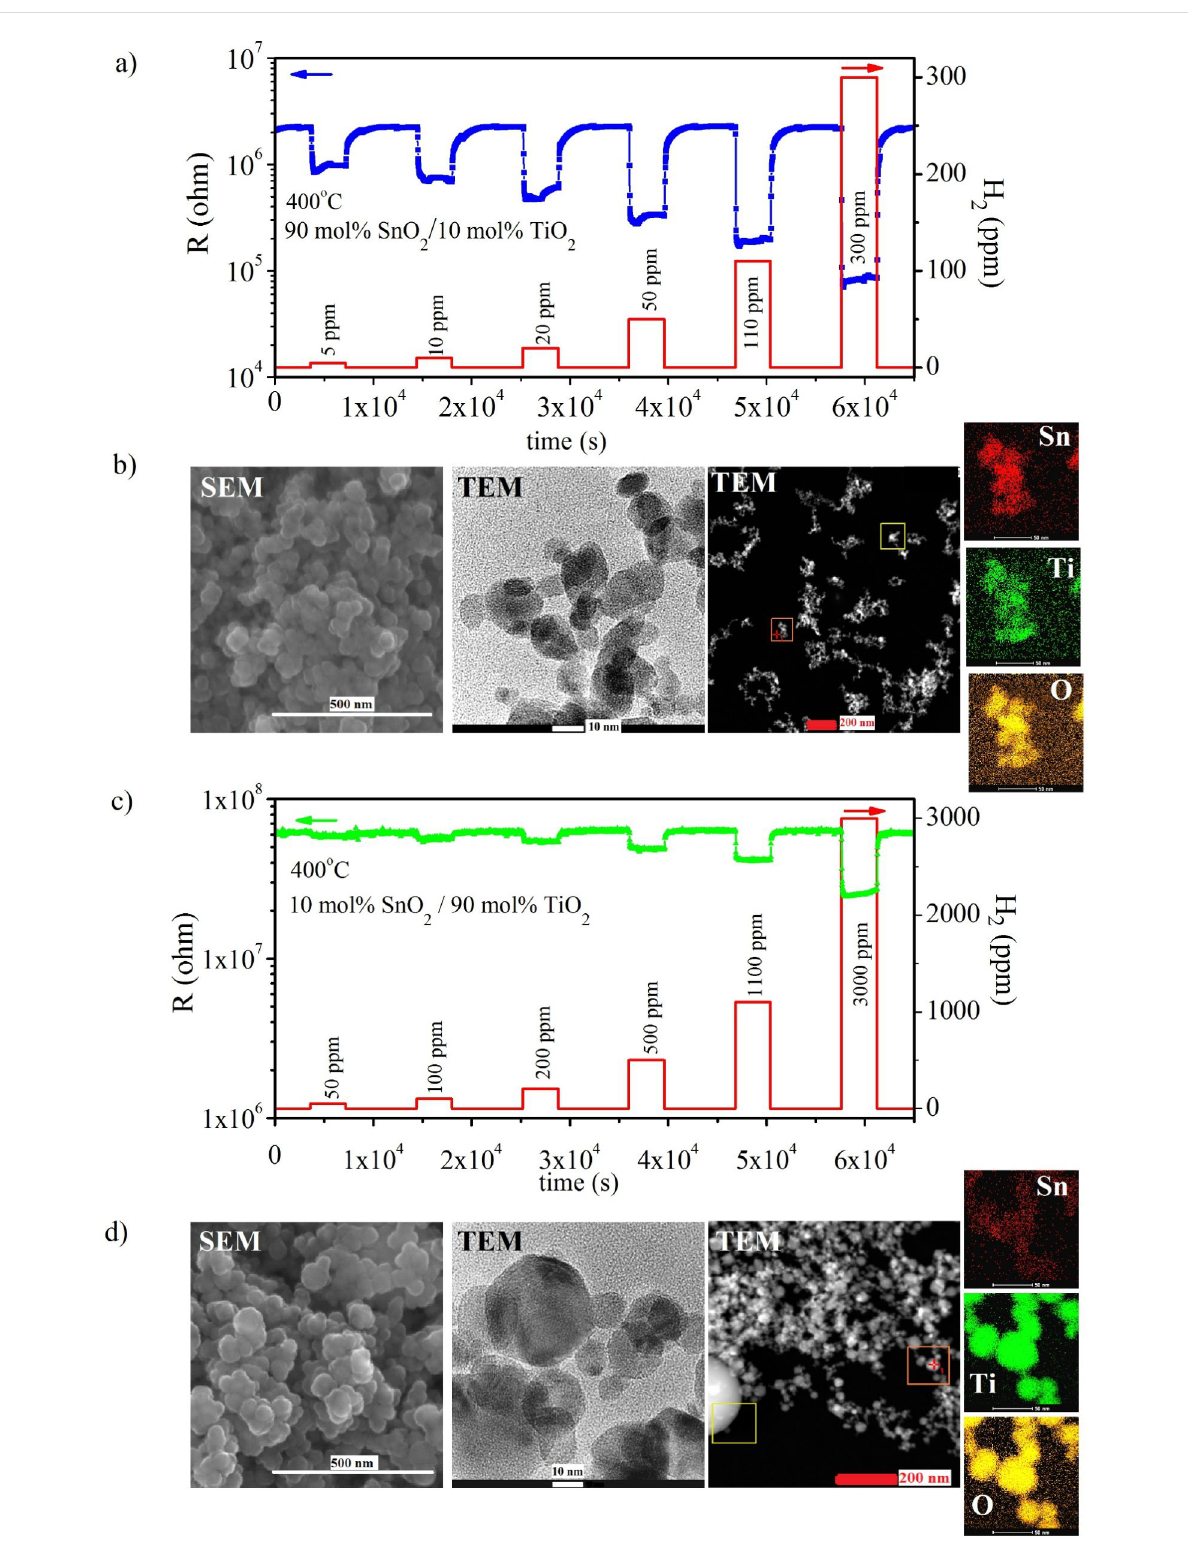
Figure 4: Dynamic changes in the electrical resistance, R , of: a) 90 mol % SnO 2 /10 mol % TiO 2 (H 2 concentration: 5–300 ppm) and c) 10 mol % SnO 2 /90 mol % TiO 2 (H 2 concentration: 50–3000 ppm) nanomaterials upon interaction with hydrogen at a constant temperature of 400 °C along with the corresponding SEM and TEM images (b, d). Step changes in hydrogen concentrations are given on the right hand scale (a,